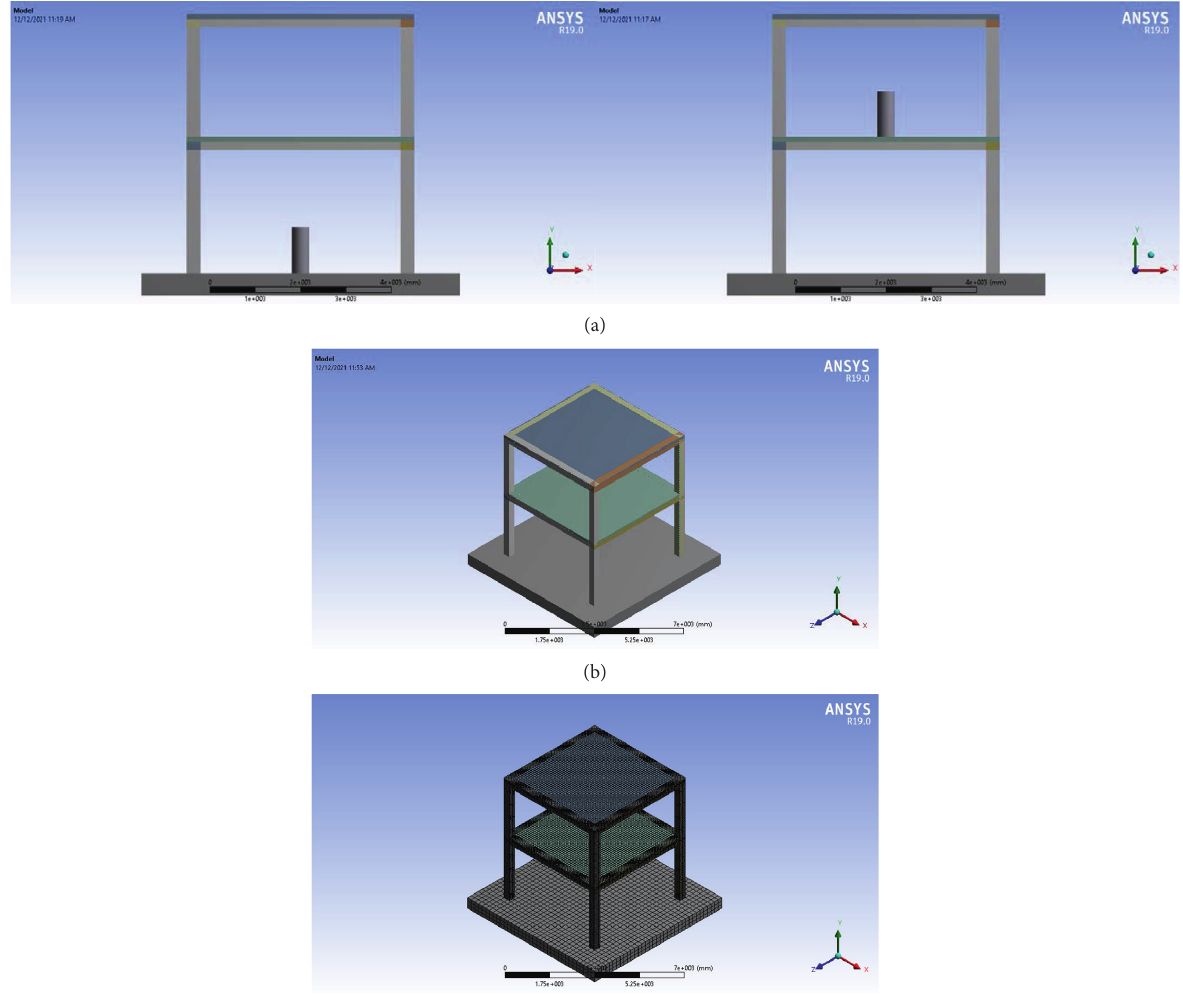
Figure 17: ANUTODYN FEA model with (a) location of TNT explosive, (b) 3D plot, and (c)